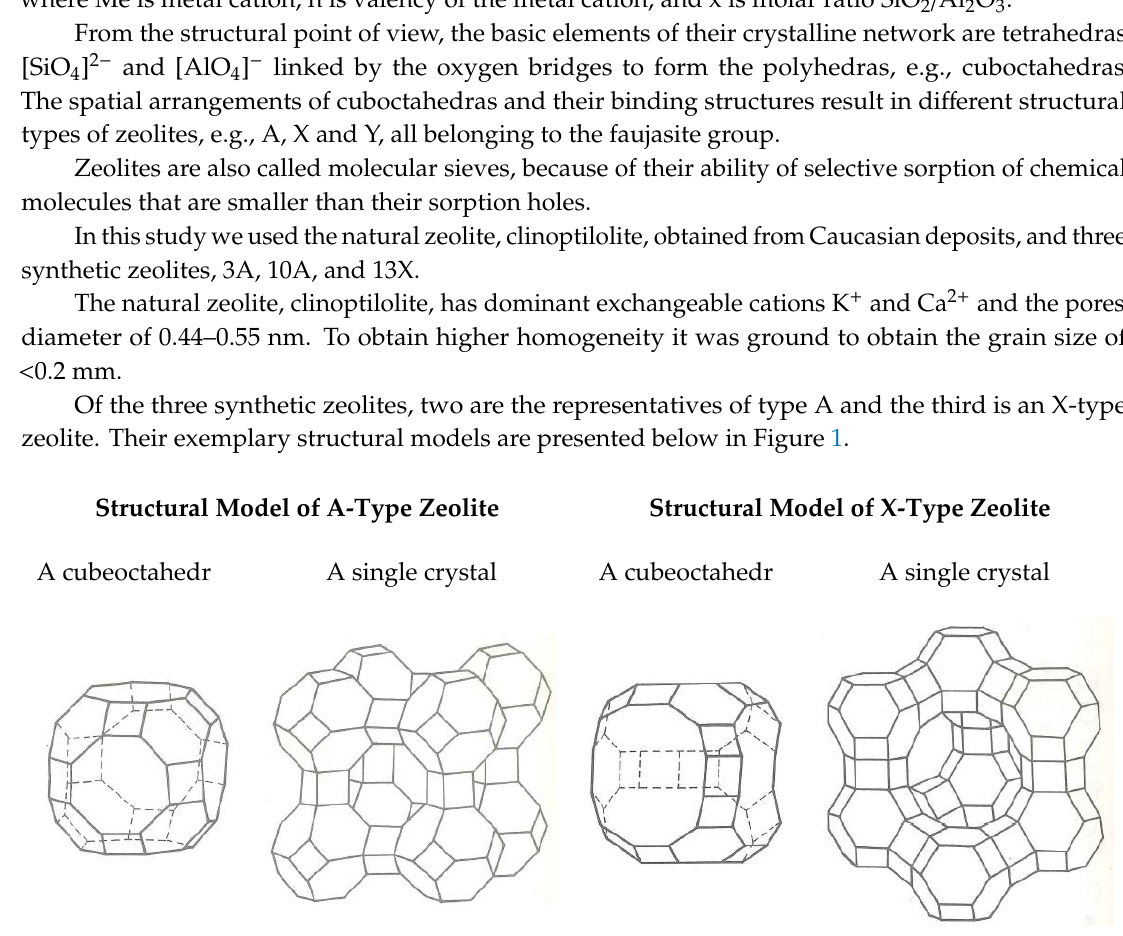
Figure 1. Exemplary structural modes of A-type and X-type synthetic zeolites used in the study. The tested synthetic zeolite 3A is a sodium-and-potassium zeolite with pores’ diameter of 0.38 nm, zeolite 10A is a sodium zeolite with pores’ diameter of 0.9–1.0 nm, and zeolite 13X is a sodium zeolite with pores’ diameter of 0.9–1.0 nm.